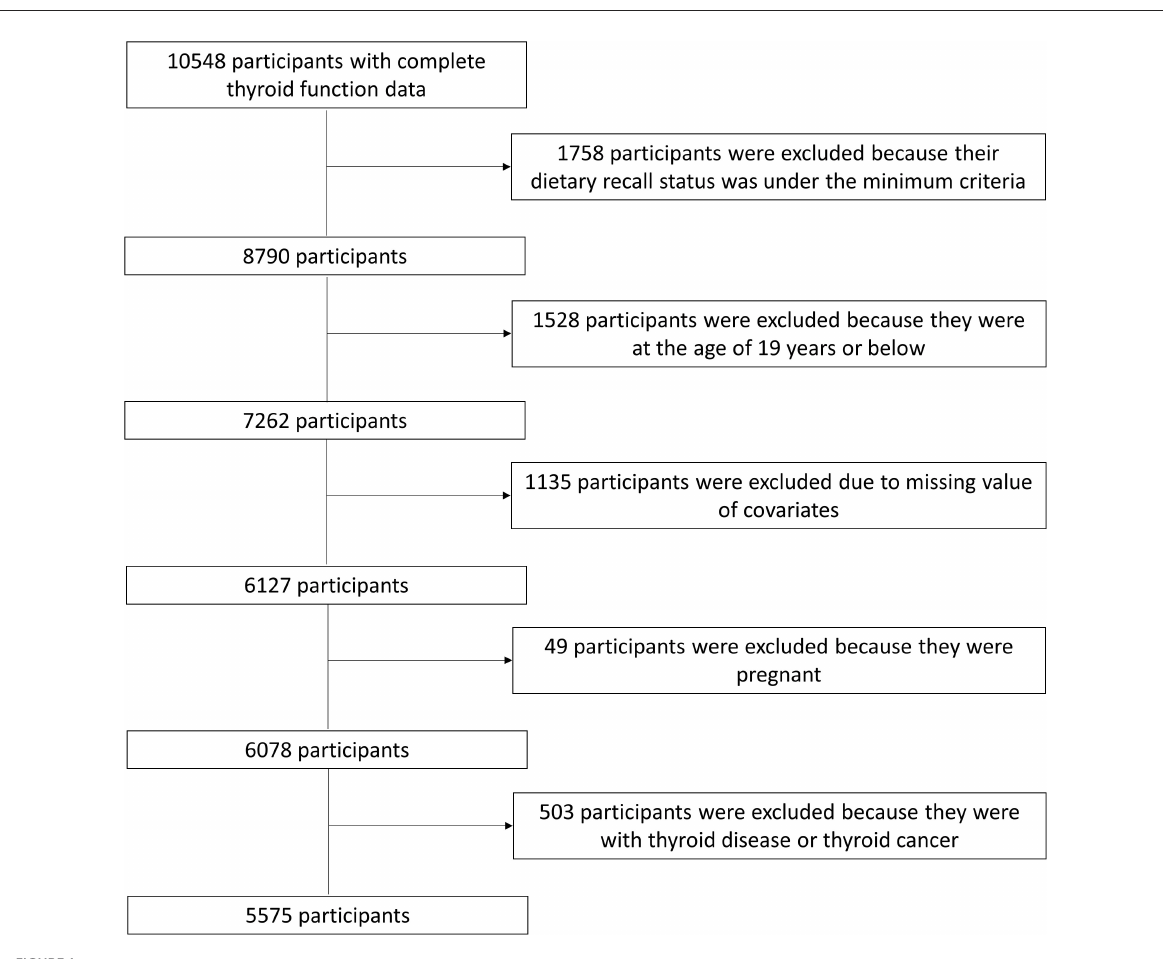
adults. The flowchart of sample selection was presented in Figure